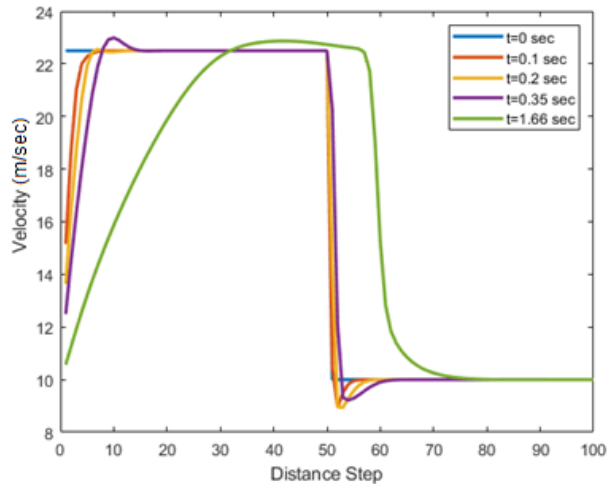
Figure 19. Velocity behavior of the proposed model on a ring road.